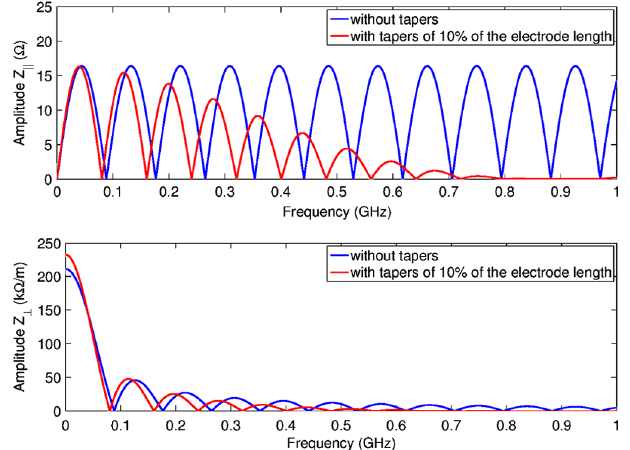
FIG. 21. Analytically calculated longitudinal beam coupling impedance (top) and transverse beam coupling impedance (bottom), for untapered and tapered half-moon electrodes with a taper length corresponding to the 10% of the electrode length.